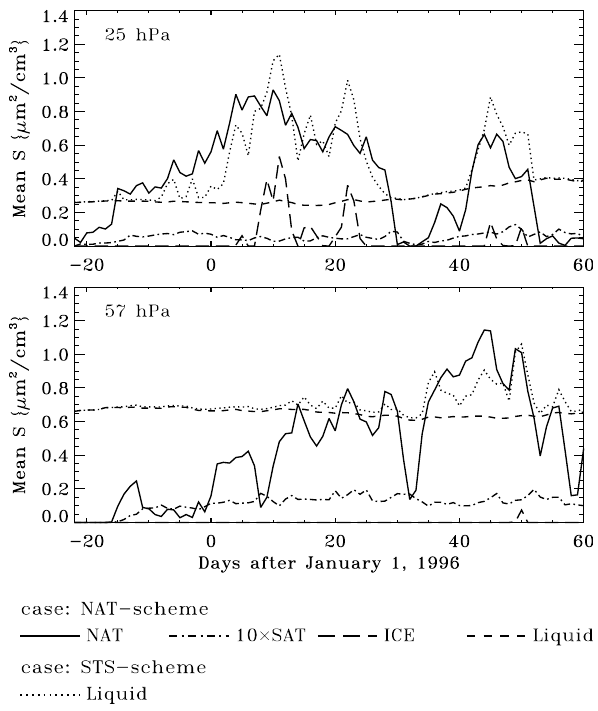
Fig. 3. Temporal change of particle surface area concentrations ( µ m 2 cm − 3 ) averaged over the area north of 45 ◦ N on the model levels (bottom frame) 57 hPa and (top frame) 25 hPa. Data is presented for the time period between 10 December 1995, and 29 February 1996, simulated in the model experiments performed with the NAT- and the STS-scheme,